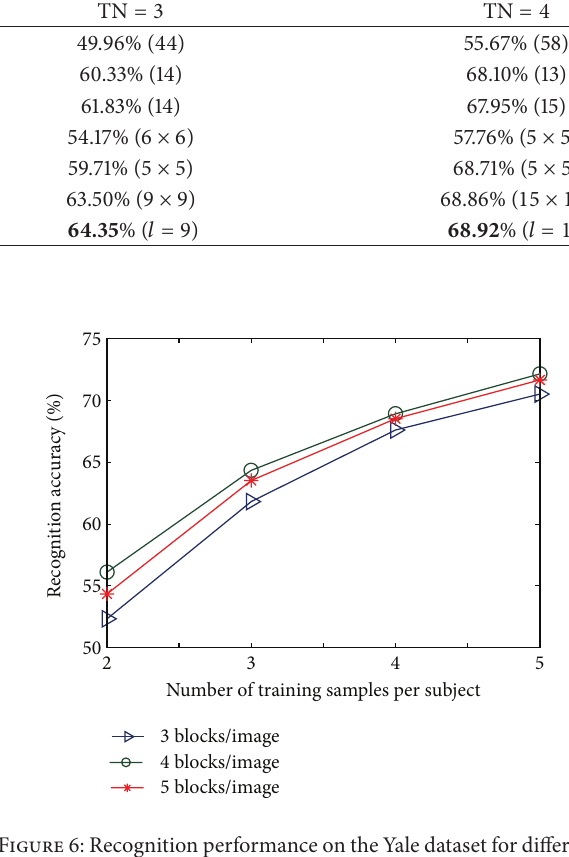
Figure 5: Recognition performance on the ORL dataset for different number of blocks per image.